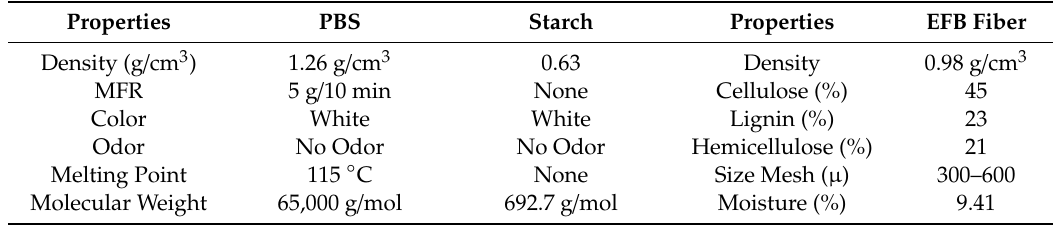
Table 1. Properties of polybutylene succinate (PBS), starch and empty fruit bunch (EFB) fiber.